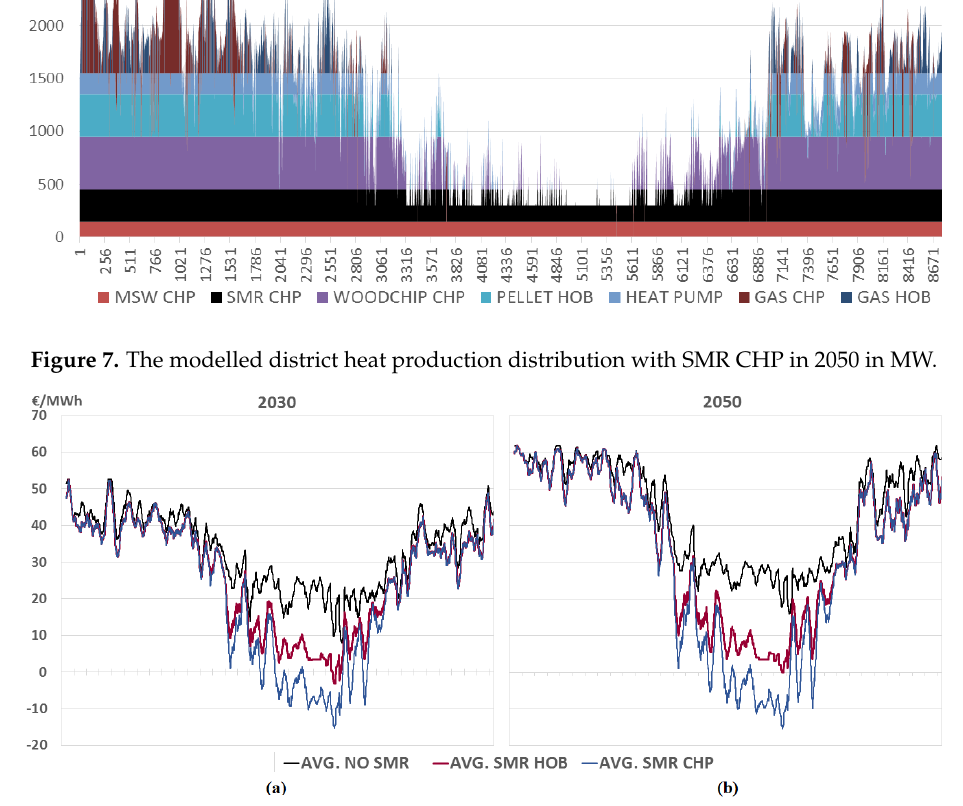
Figure 8. The marginal cost of district heat production over a year in 2030 ( a ) and 2050 ( b ) using a 100 h moving average.